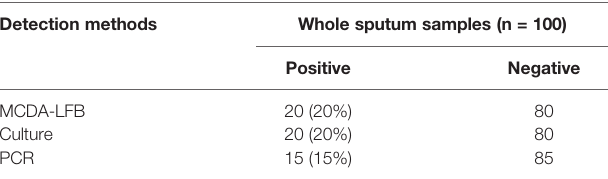
TABLE 3 | Comparison of PCR, culture-biotechnical, and MCDA-LFB assays for the detection of Aspergillus fumigatus in sputum samples of human. Detection